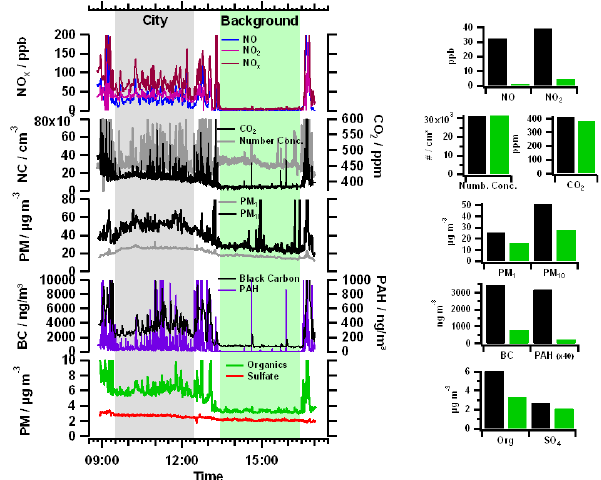
Fig. 6. The mobile laboratory during an autonomous stationary measurement at the coast in northern Spain during a field measure- ment campaign in June 2011. The engine’s emissions are removed using the active exhaust removal system, which releases the pollu- tants 25m downwind of the vehicle to avoid self-contamination.